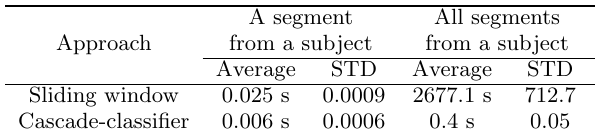
Figure 4: The classifiers performance Table 4: Running